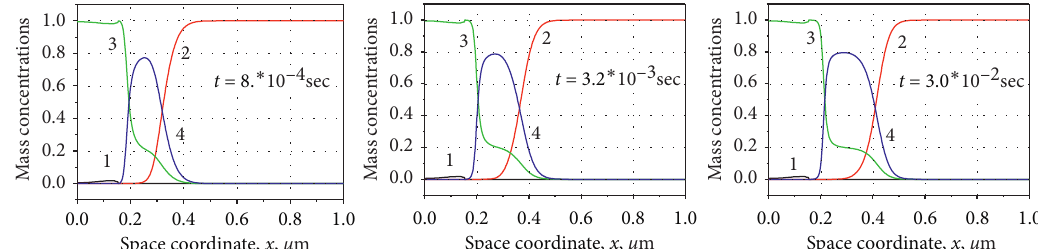
Figure 2: Distribution of phases and elements at various times at a temperature T � 1000K for a “fast” process: a steady